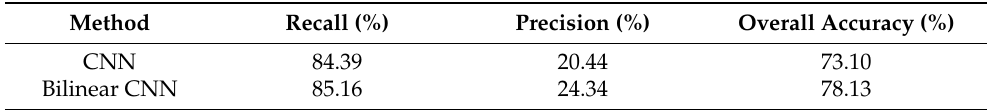
Table 4. Performance comparison with Bilinear CNN and CNN with score threshold = 0.05 in our constructed